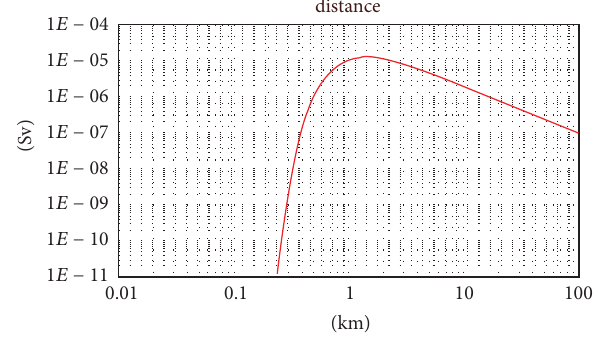
Figure 1: TEDE as a function of downwind distance from the NPP site in D